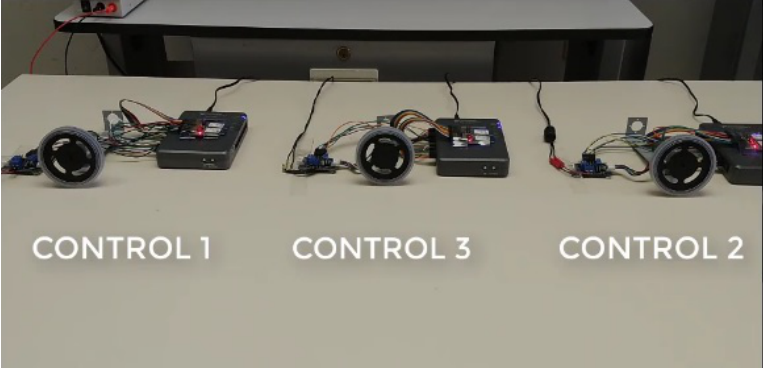
Figure 2. Experimental agent interconnection diagram.